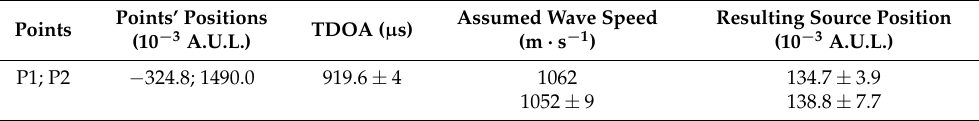
Table 4. Multi-sensor localization with P1 and P2—results (actual source position: 135.3 × 10 − 3 A.U.L.).